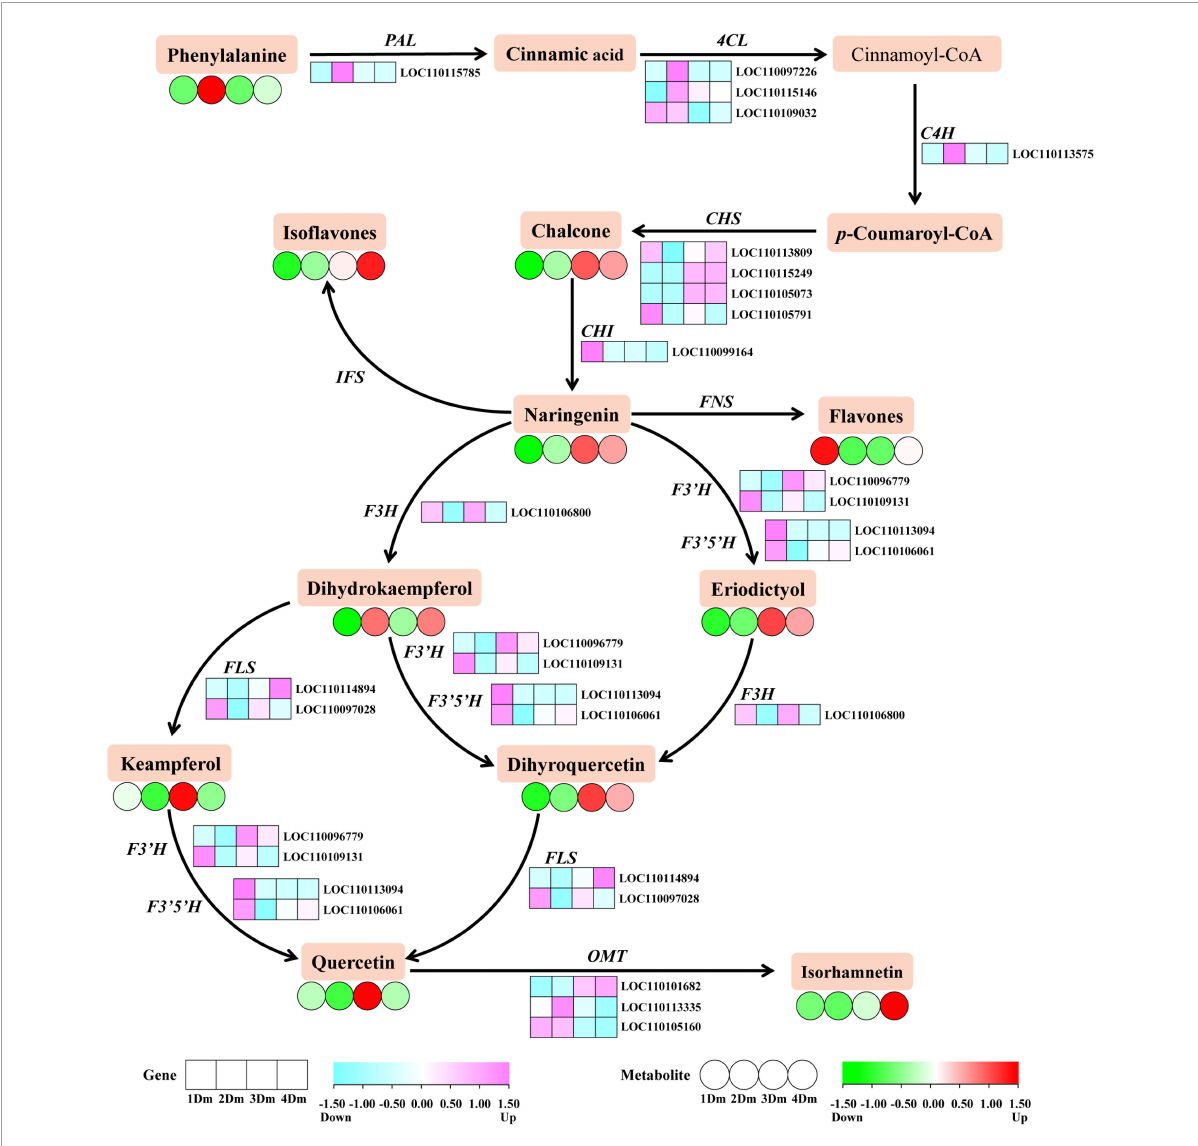
FIGURE2 The flavonoids biosynthetic pathway of D. moniliforme . The heatmap shows the expression patterns of DEGs and DAMs during flavonoid biosynthesis. The rectangles represent the expression changes of DEGs and the circles represent the expression changes of DAMs. The color scale indicates the relative amounts of DEGs and DAMs. Darker colors indicate higher expression. Pink represents up-regulated DEGs, and blue represents down-regulated DEGs. Red represents up-regulated DAMs and green represents down-regulated DAMs. Key enzyme gene abbreviation: C4H, cinnamate 4-hydroxylase; PAL, phenylalanine ammonia lyase; 4CL, 4-coumarate: CoA ligase; CHS, chalcone synthase; CHI, chalcone isomerase; F3H, flavonoid 3-hydroxylase; F3’H, flavonoid 3’-hydroxylase; FLS, flavonol synthase; IFS: isoflavone synthase; FNS, flavone synthase; OMT,